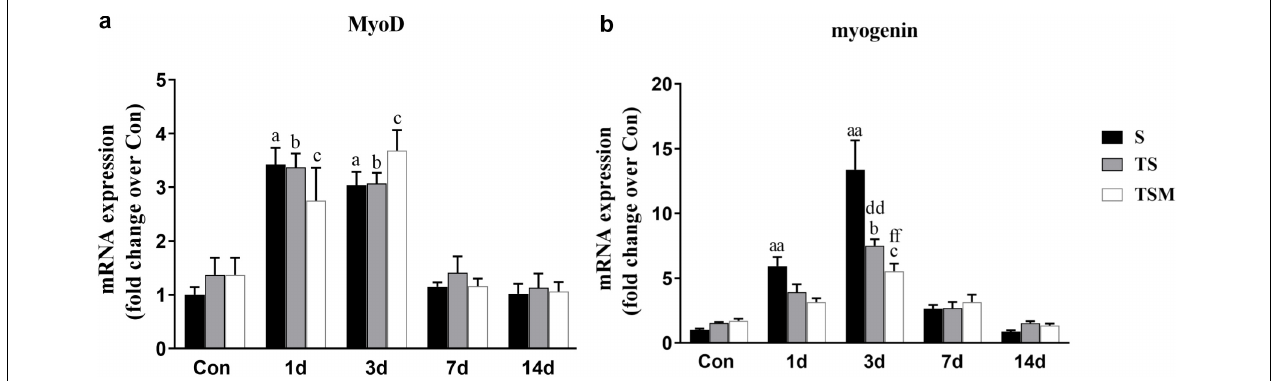
FIGURE 6 | Effects of MGF treatment on the expression of MyoD and myogenin. (a) The expression of MyoD; (b) The expression of myogenin. S, muscle contusion group; TS, muscle contusion and macrophage depleted group; TSM, muscle contusion, macrophage depletion and MGF treated group. Data are means ± SEM, n = 8; a Significant difference from Scon, p < 0.05; aa p < 0.01. b Significant difference from TScon, p < 0.05; bb p < 0.01. c Significant difference from TSMcon, p < 0.05; cc p < 0.01; d Significant difference between group TS and group S, p < 0.05; dd p < 0.01; e Significant difference between group TS and group TSM, p < 0.05; ee p < 0.01; f Significant difference between group TSM and group S, p < 0.05; ff p <